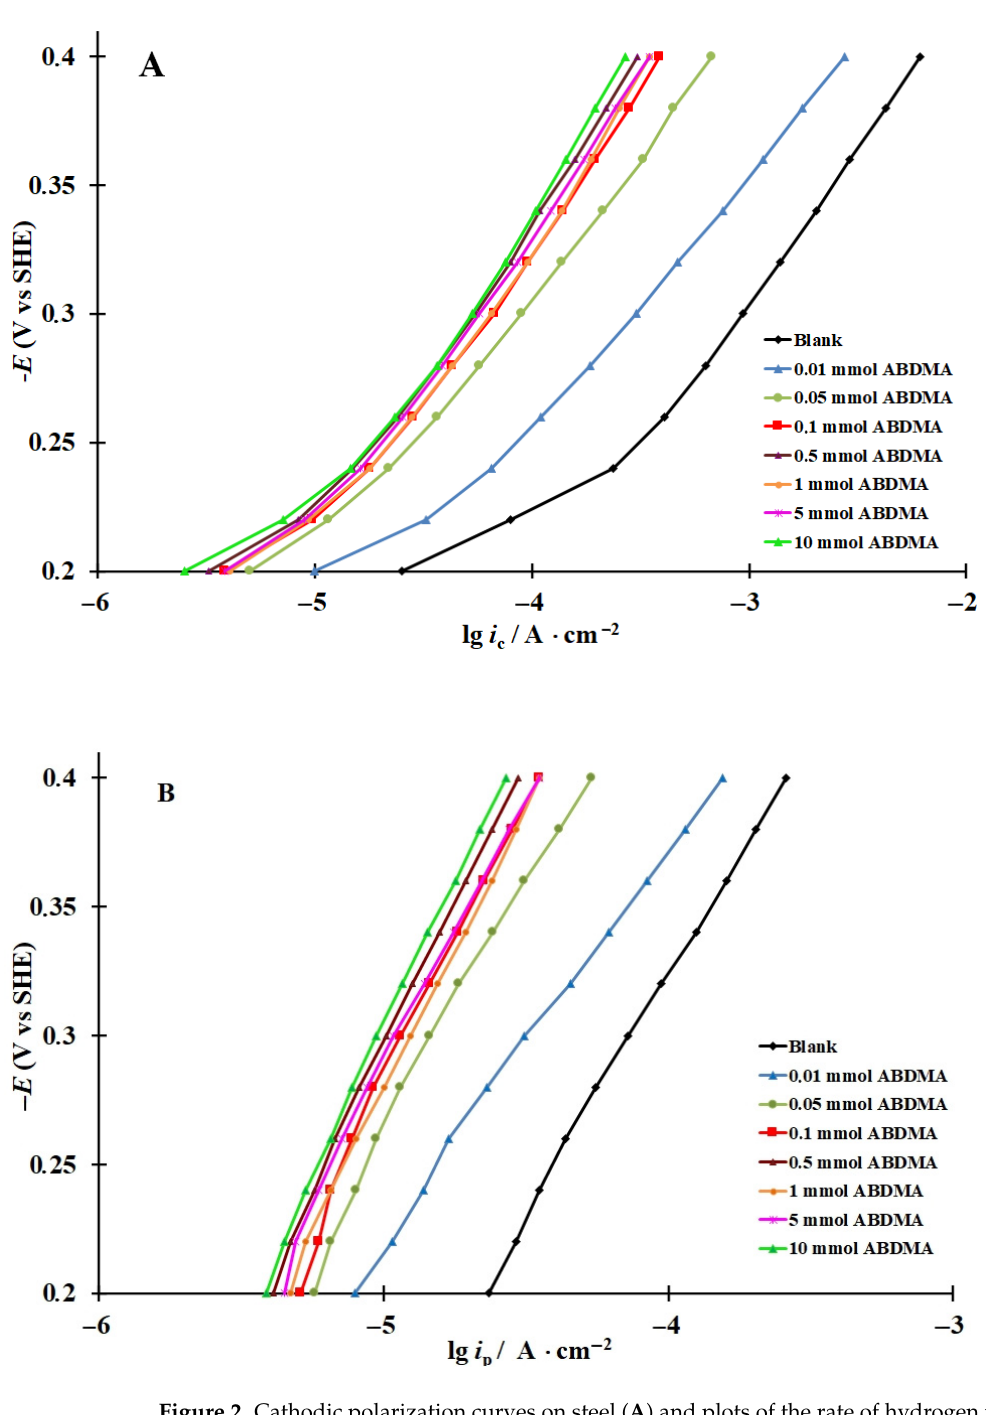
Figure 2. Cathodic polarization curves on steel ( A ) and plots of the rate of hydrogen penetration into steel vs. potential ( B ) in 2 M HCl containing ABDMA.